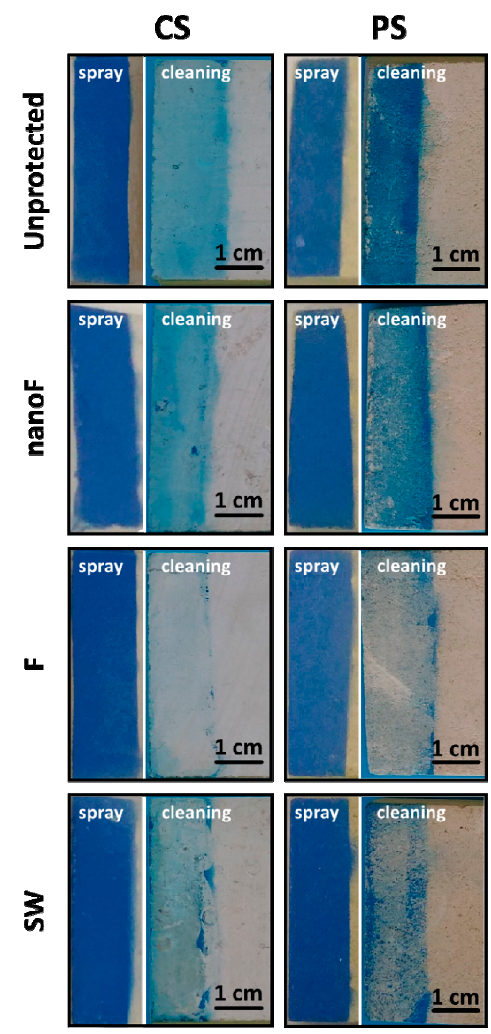
Figure 8. Protected and unprotected stone samples after the staining by spray paint and after the cleaning procedure (CS = compact stone; PS = porous stone); the neat surface is on the right of each image.